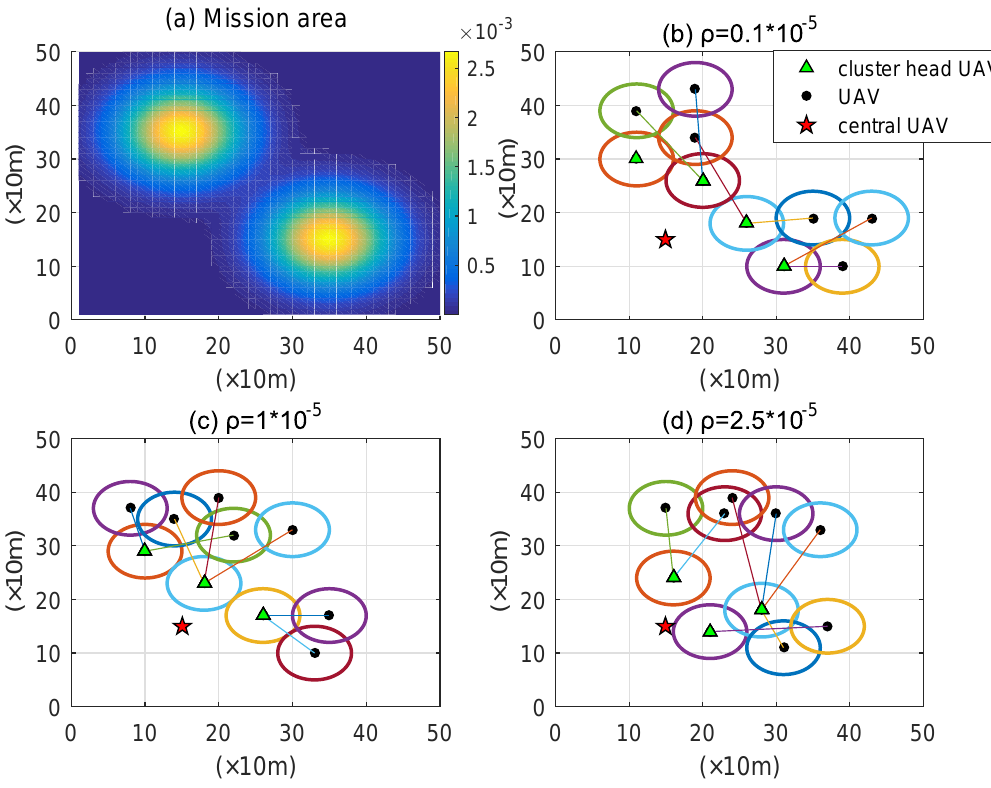
Figure 2. The diagram of 10 UAV deployment and coalition formations under the proposed algorithm: ( a ) Color-coded display of the density map for the mission area; ( b ) UAV deployment and coalition formations with ρ = 0.1 × 10 − 5 ; ( c ) UAV deployment and coalition formations with ρ = 1 × 10 − 5 ; ( d ) UAV deployment and coalition formations with ρ = 2.5 × 10 − 5